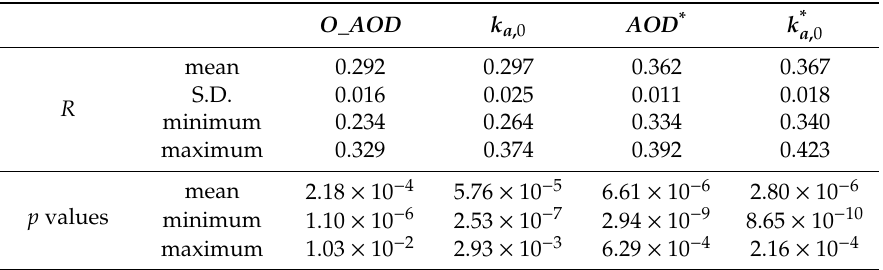
Table 2. Descriptive statistics of Pearson correlation coe ffi cients ( R ) and correlation tests between GF-1 uncorrected aerosol optical depth ( O_AOD ) or humidity-corrected AOD ( AOD* ) and PM 2.5 concentrations, together with the corresponding correlations with uncorrected and humidity-corrected near-surface extinction coe ffi cients ( k a ,0 , and k ∗ ). AOD were determined at spatial scales ranging from a ,0 40 to 5000 m. O_AOD k a , 0 AOD * k * a , 0 mean 0.292 R